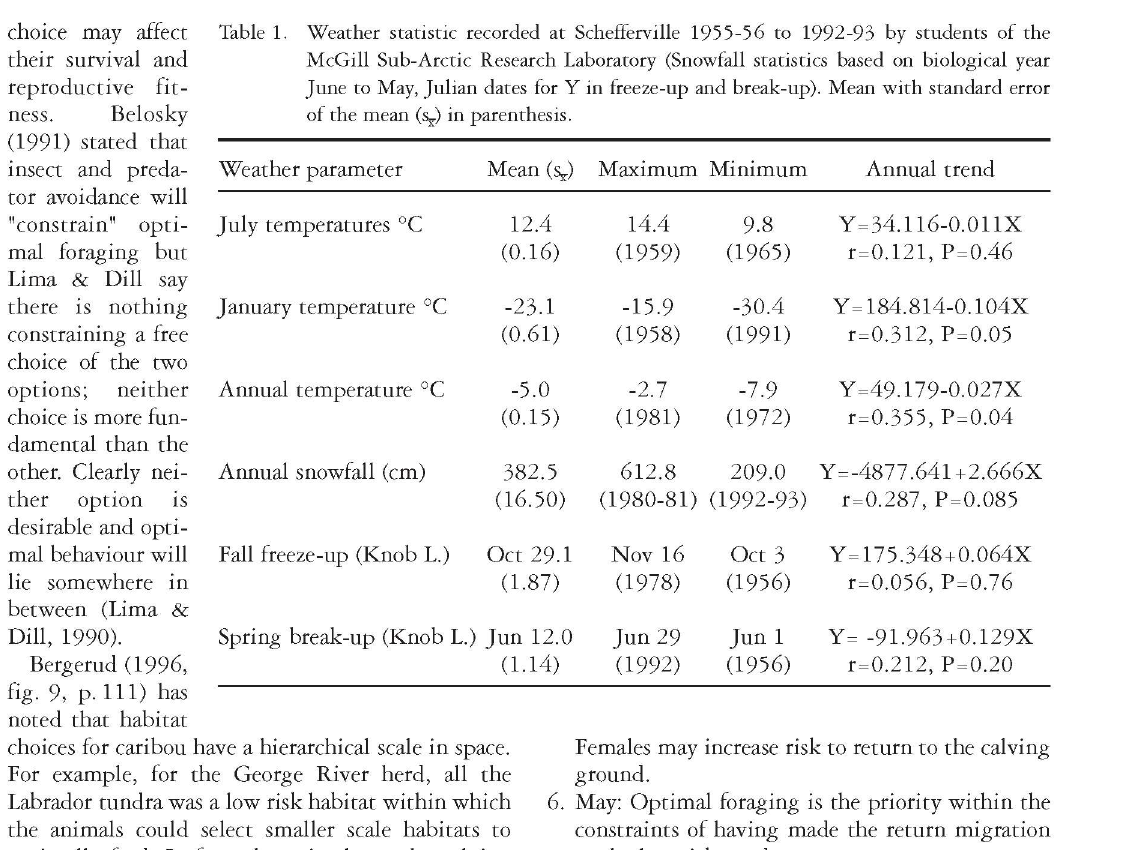
Table 1. Weather statistic recorded at Schefferville 1955-56 to 1992-93 by students of the McGill Sub-Arctic Research Laboratory (Snowfall statistics based on biological year June to May, Julian dates for Y in freeze-up and break-up). Mean with standard error of the mean (s x) in